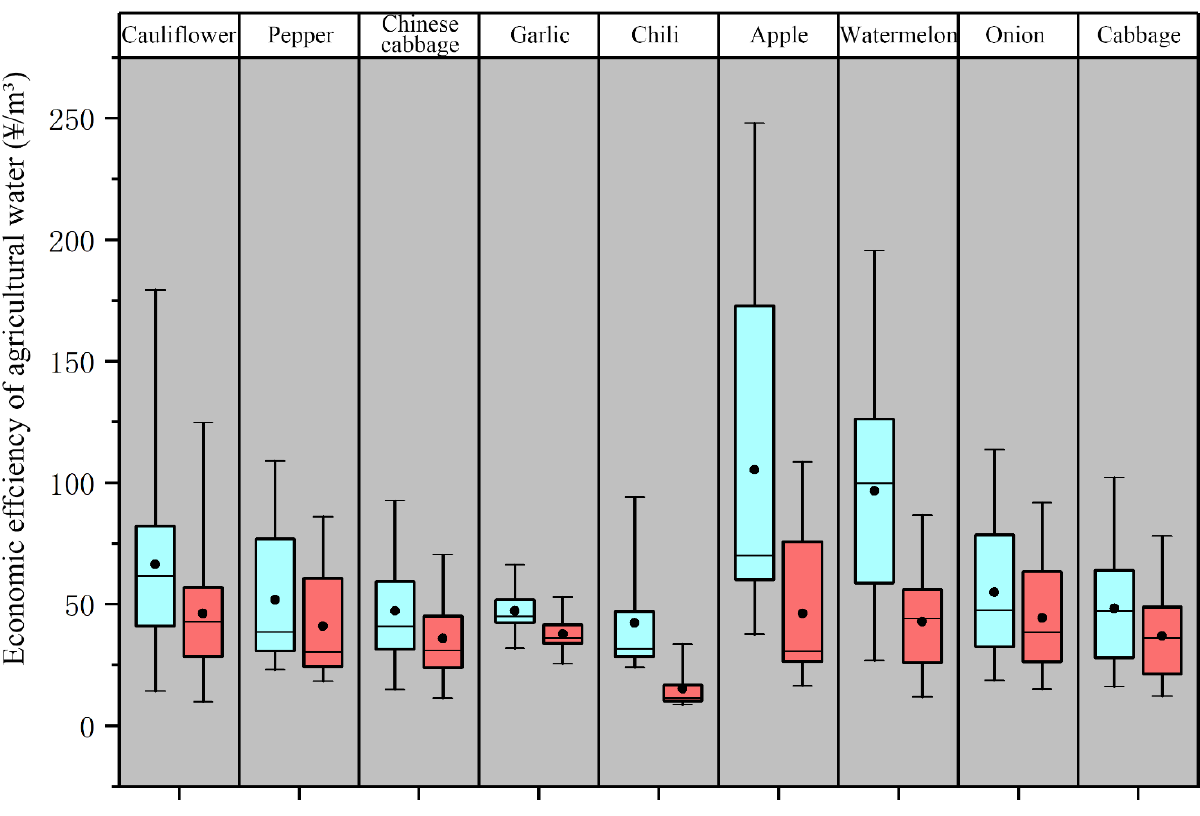
12 of 19 Figure 7. The price of different crops during the year in 2019. (The vertical axis is crop price, ¥/kg.